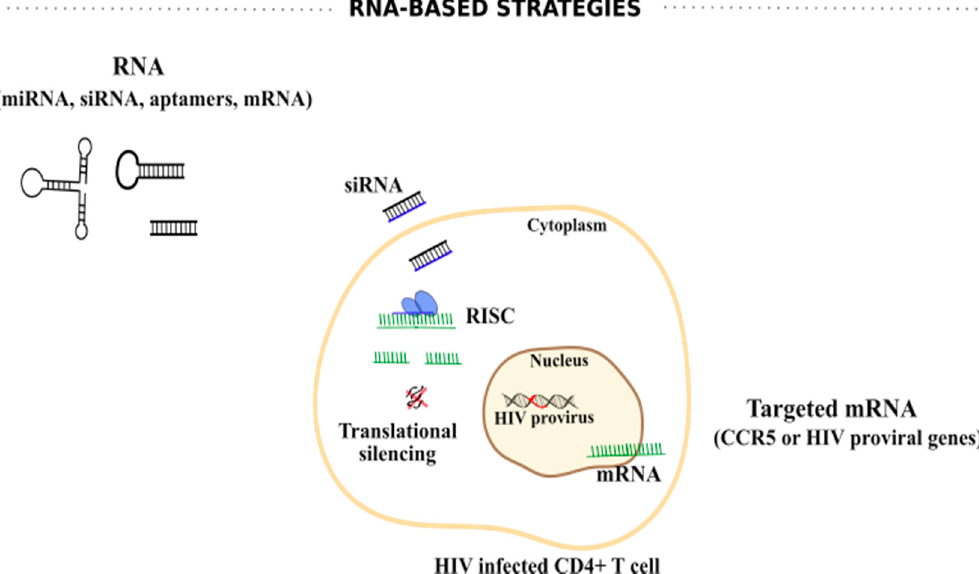
Figure 4. RNA-based strategies against HIV infection. RNA-based strategies include the use of miRNAs, siRNAs, RNA aptamers, and mRNAs. These RNAs can be synthesized to specifically bind to CCR5, the major co-receptor for HIV entry, or bind to crucial regions into HIV proviral genome. siRNAs assemble with cellular host proteins to form an RNA-induced silencing complex (RISC). Only one strand (guide) is maintained and produces an active RISC that triggers the targeted mRNA degradation, culminating in translational